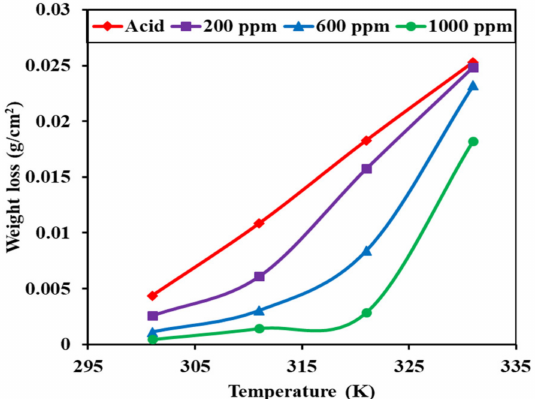
Figure 7. Variations in the weight-loss of mild steel coupons in the 1 M H 2 SO 4 solution and the 200, 600, and 1000 ppm inhibitor solutions at different